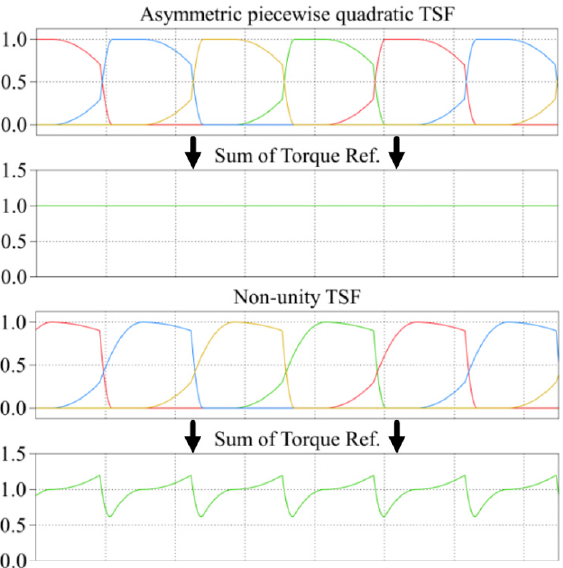
Figure 9. Torque references for the individual phases and the total sum of